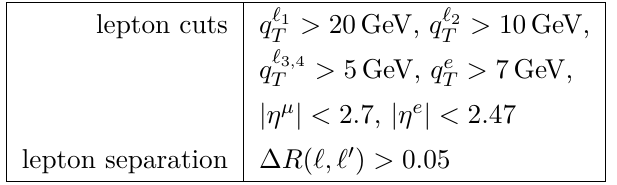
√ s = 13 TeV presented in ref. [24].